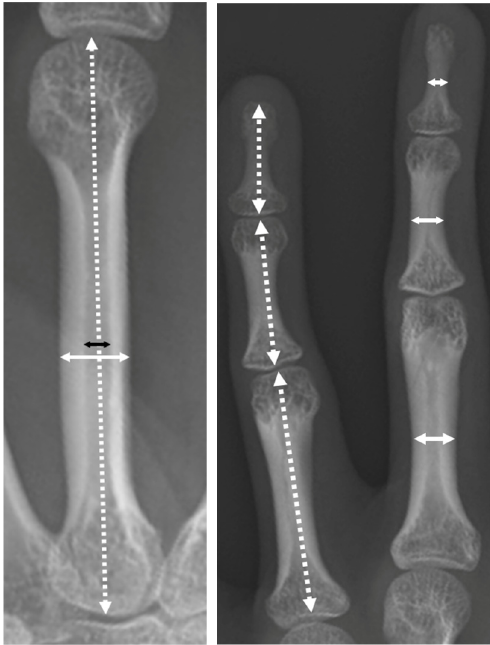
Figure 3. The two-headed arrows of the white dotted line indicate the length of the metacarpal bones and distal, middle, and proximal phalanges. The two-headed arrows of the white solid line indicate the width of the metacarpal bones and distal, middle, and proximal phalanges. The black two-headed arrows indicate the width of the third metacarpal medullary cavity.